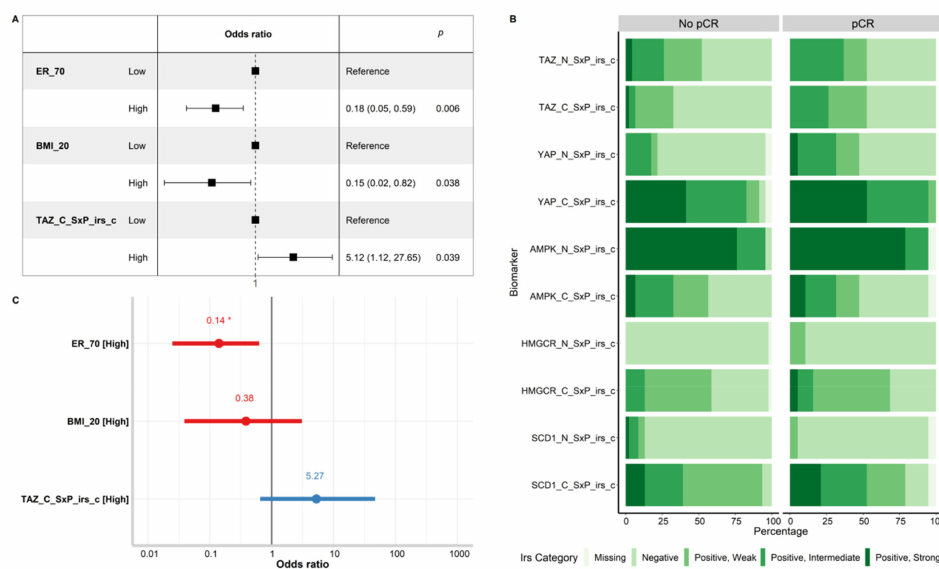
Figure 4. Panel ( A ) displays the univariate logistic model for the variables that showed a statistically significant effect on pCR. Panel ( B ) shows the stacked bar plots of the biomarker expression level in terms of categorized international immunoreactive score (SxP_irs_c), comparatively for tumors that reached pCR and those which did not (No pCR). Panel ( C ) shows the multivariate logistic model which includes all the variables showing a significant impact on pCR in the univariate model. Abbreviations: ER_70 = estrogen receptor with cut-off at 70% (ER > 70% vs. Others); BMI_20 = body mass index with cut-off of 20 (BMI > 20 vs. Others). Suffixes: _C = cytoplasmic. In Panel ( C ), * represents p < 0.05, as the only statistical significance level.